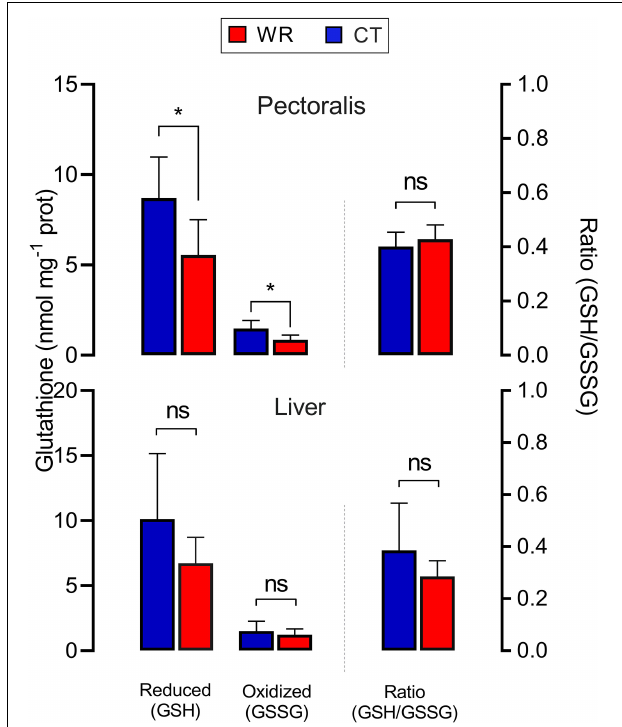
FIGURE 6 | Reduced and oxidized glutathione concentrations (left axis) and reduced/oxidized glutathione ratio (right axis) in pectoral and liver of Z. capensis acclimated to hydrated and dehydrated conditions. Data are reports as mean ± SE. Asterisks denote significant differences between